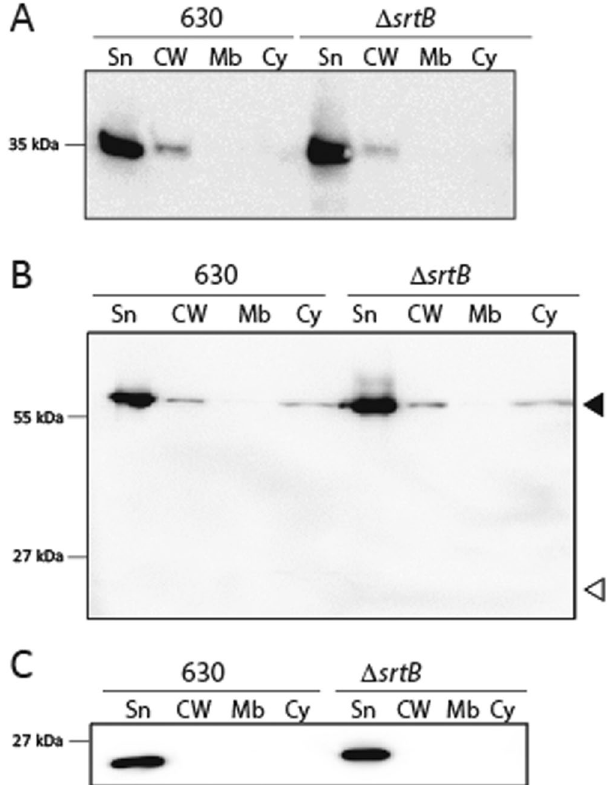
protein (pHAS039) ( B ), or plasmid encoded CD2768 HA (pJKP077) ( C ) were fractionated into supernatant (Sn), cell wall (CW), membrane (Mb) and cytoplasm (Cy) compartments. Protein fractions were analysed by western blot using anti-0183 antibody ( A ), anti-CwpV antibody ( B ), or anti-HA tag antibody ( C ). ◀, uncleaved CD0183-CwpV; ◁, size of expected fragment containing CwpV repeats. Western blots were cropped for clarity; uncropped images can be found in Supplementary Fig.